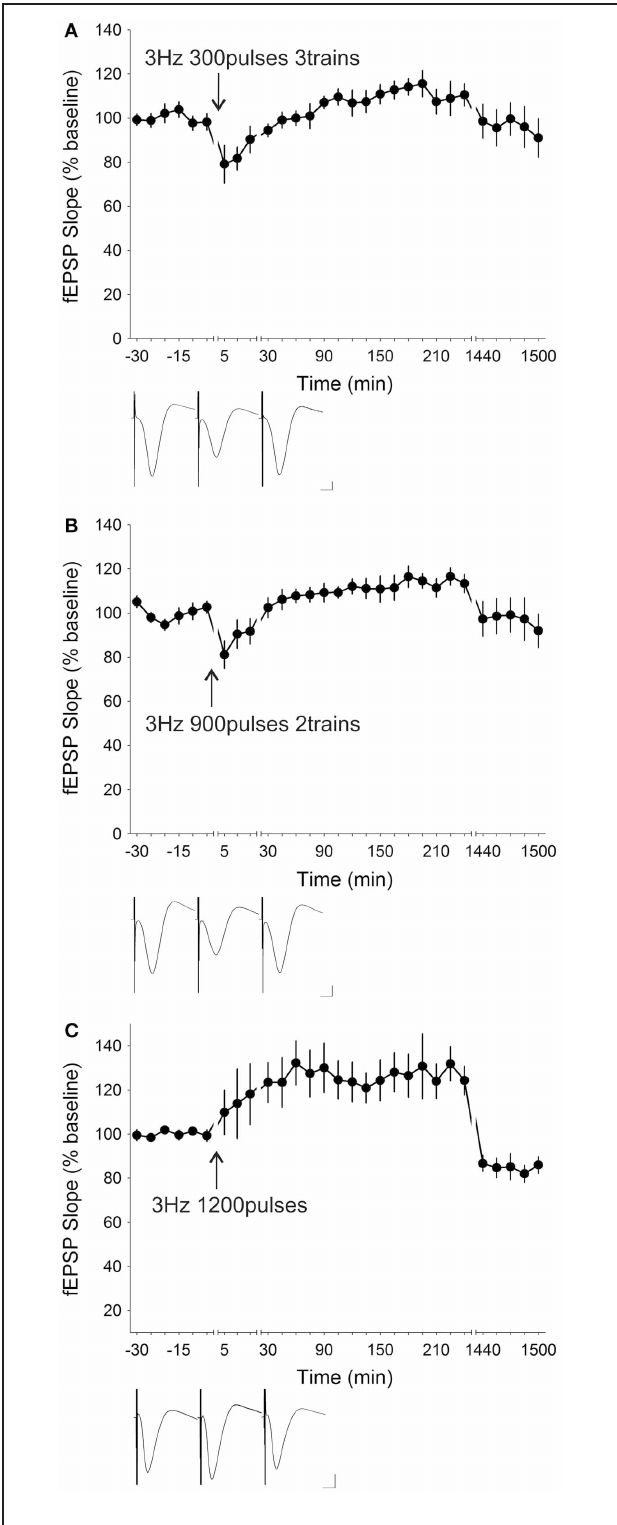
FIGURE 6 | Varying the pattern of stimulation or increasing the number of stimuli at 3Hz did not enhance but ameliorated synaptic depression. (A) Application of 900 stimuli in 3 trains of 300 stimuli (5min